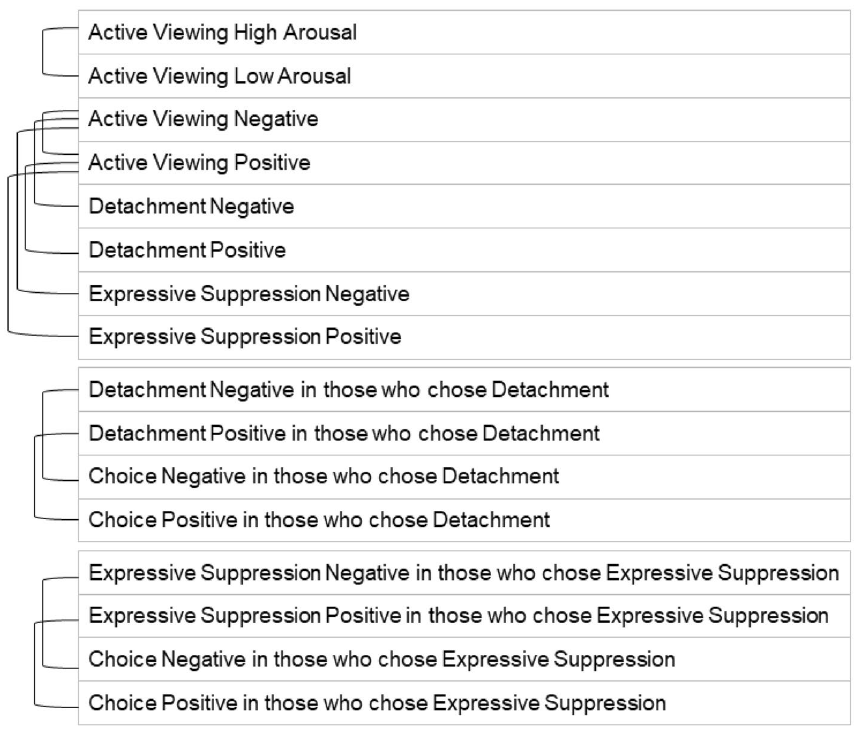
Figure 6. Conditions of interest and their comparisons. The upper eight conditions were computed by averaging the data across all participants. The lower eight conditions were computed by averaging the data of those participants who chose the same strategy in the last block. Brackets on the left indicate which conditions were compared with each other in the